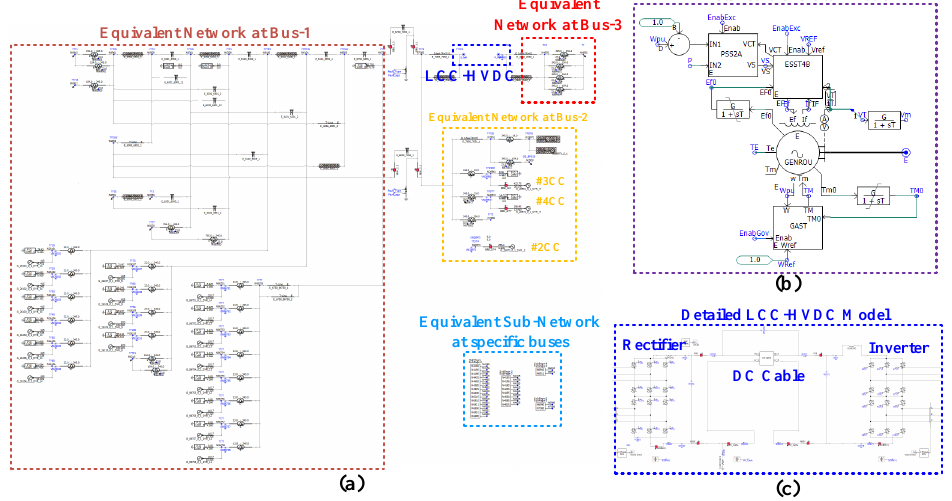
Figure 8. The PSCAD/EMTDC model for detailed TOV study by LCC-HVDC control and fault sequence. ( a ) Equivalent circuit. ( b ) Detailed generator model. ( c ) Thyristor-based 12-pulsed